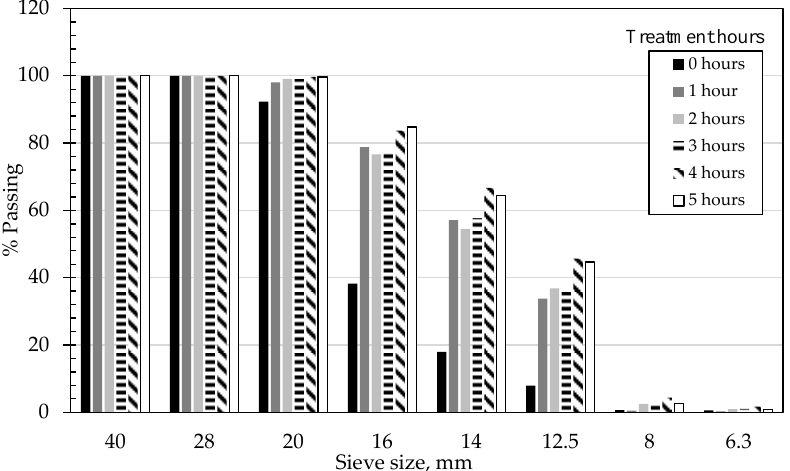
Figure 5. Effect of treatment hours on the particle size distribution of 8/20 mm NA.